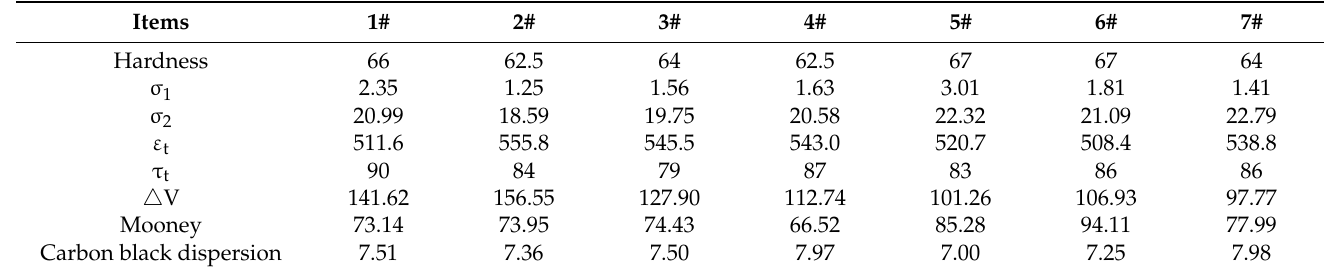
Table 5. Results data of experiments for vulcanizate properties after extrusion.